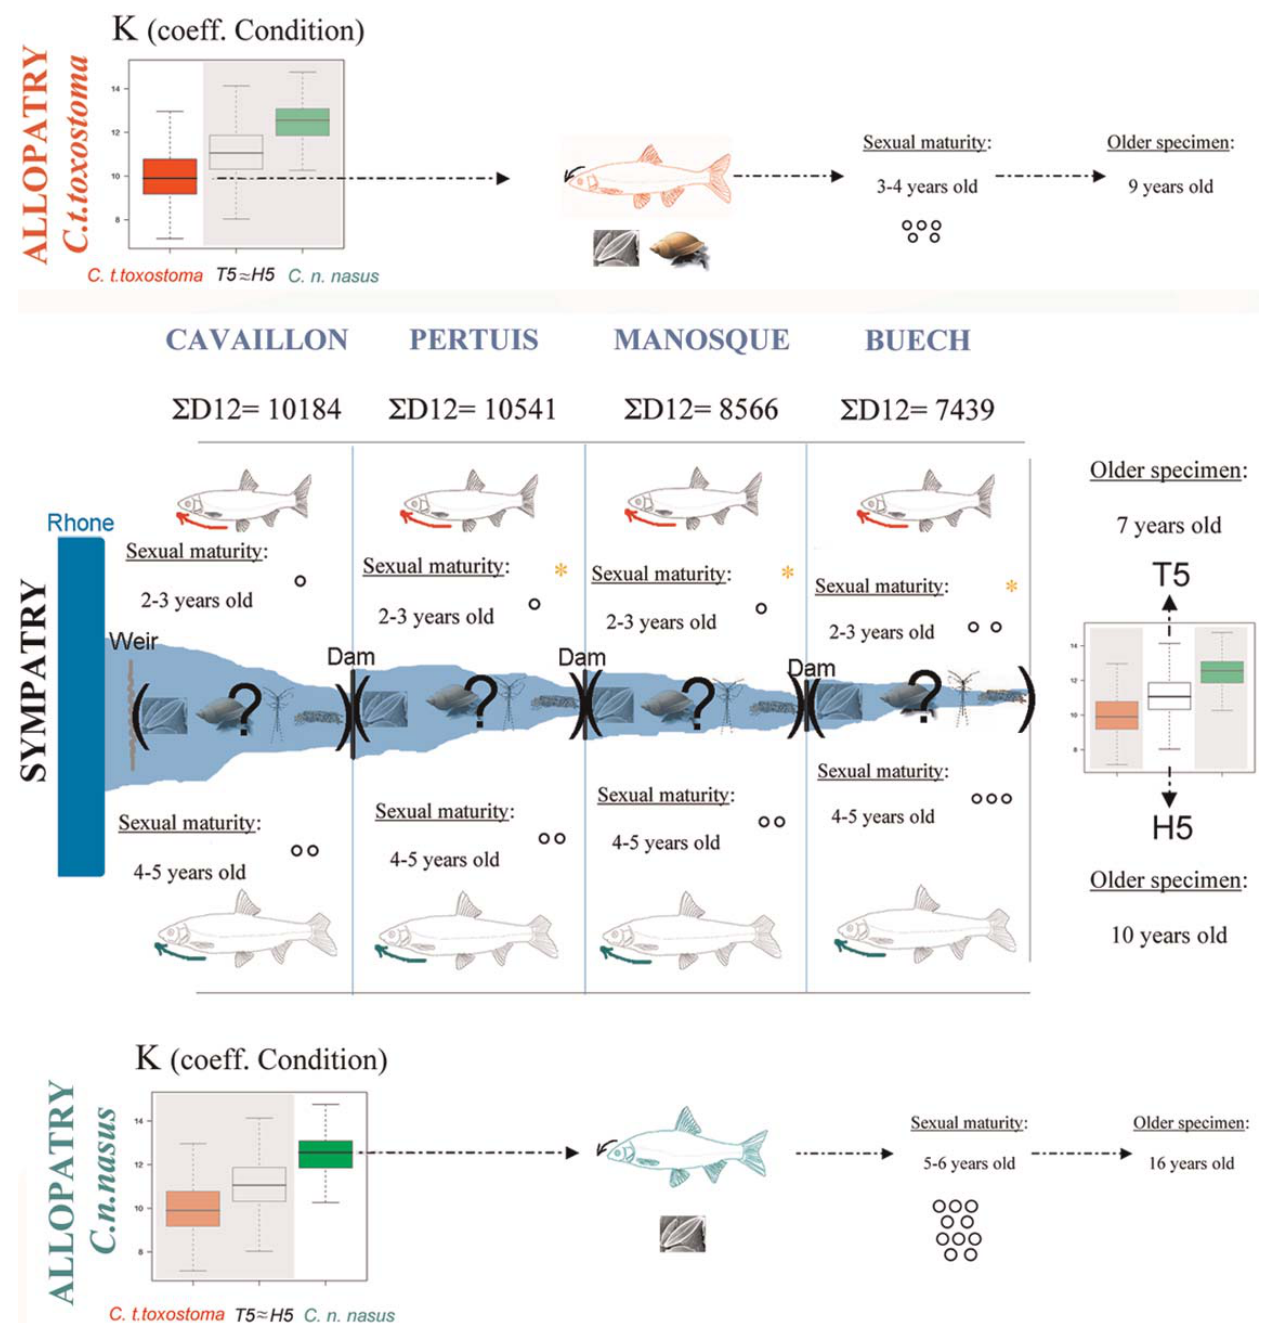
Figure 7. LIFE HISTORY TRAITS EVOLUTION THROUGH THE HYBRID ZONE. Global summary of changes in ecological and morphological traits in the hybrid zone with respect to the reference populations (see the text for more detail). Arrows indicate the overall trend for overall changes in snout orientation, ‘‘?’’ indicates that we could not strictly determine the diet of the Chondrostoma specimens in the hybrid zone, * indicates a significant difference, the other tests could not be done because the sample was too small, but we extrapolated a trend. ‘‘ S D12’’ indicates the sum of degree- days above 12 u C for each station (mean established for an 8-year data set) Chappaz (personal communication).